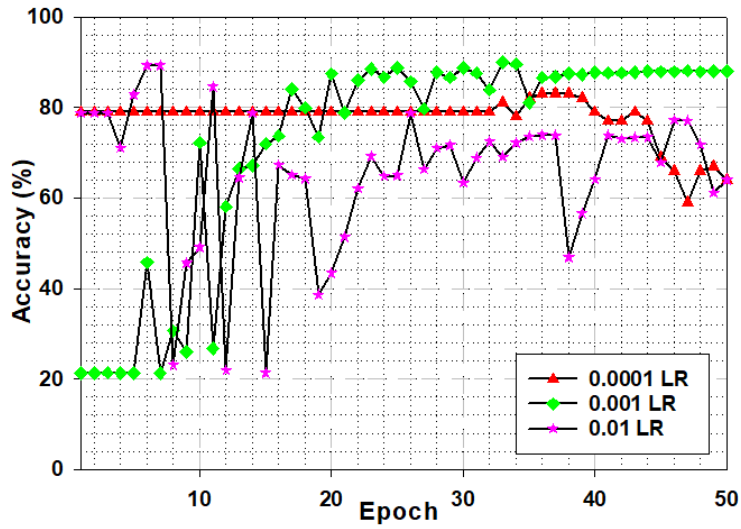
Figure 6. Accuracy by epoch for three learning rates (LR) used for training the convolutional neural network.